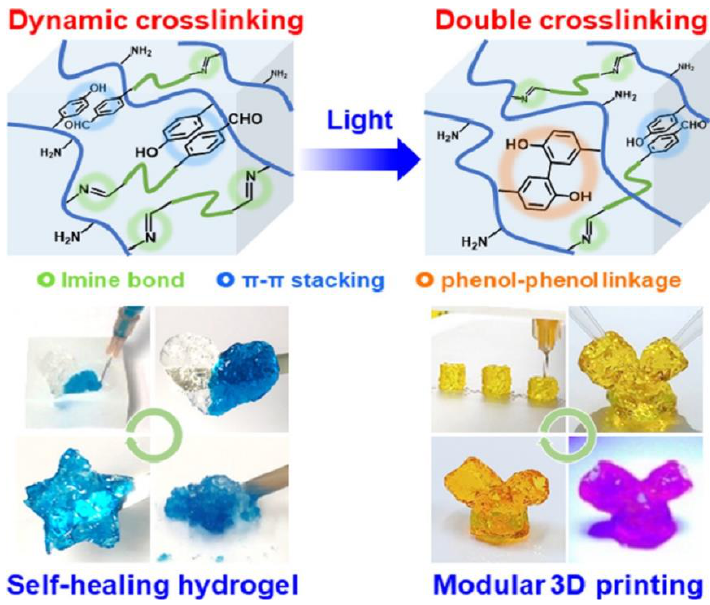
Figure 11. Schematic illustration for preparation of CPDP hydrogel by dynamic benzoic imine crosslinking between Chi-P and DF-PEG and after light crosslinking. Filament formation after each method of crosslinking. Reprinted from [34], Copyright 2021, Elsevier.